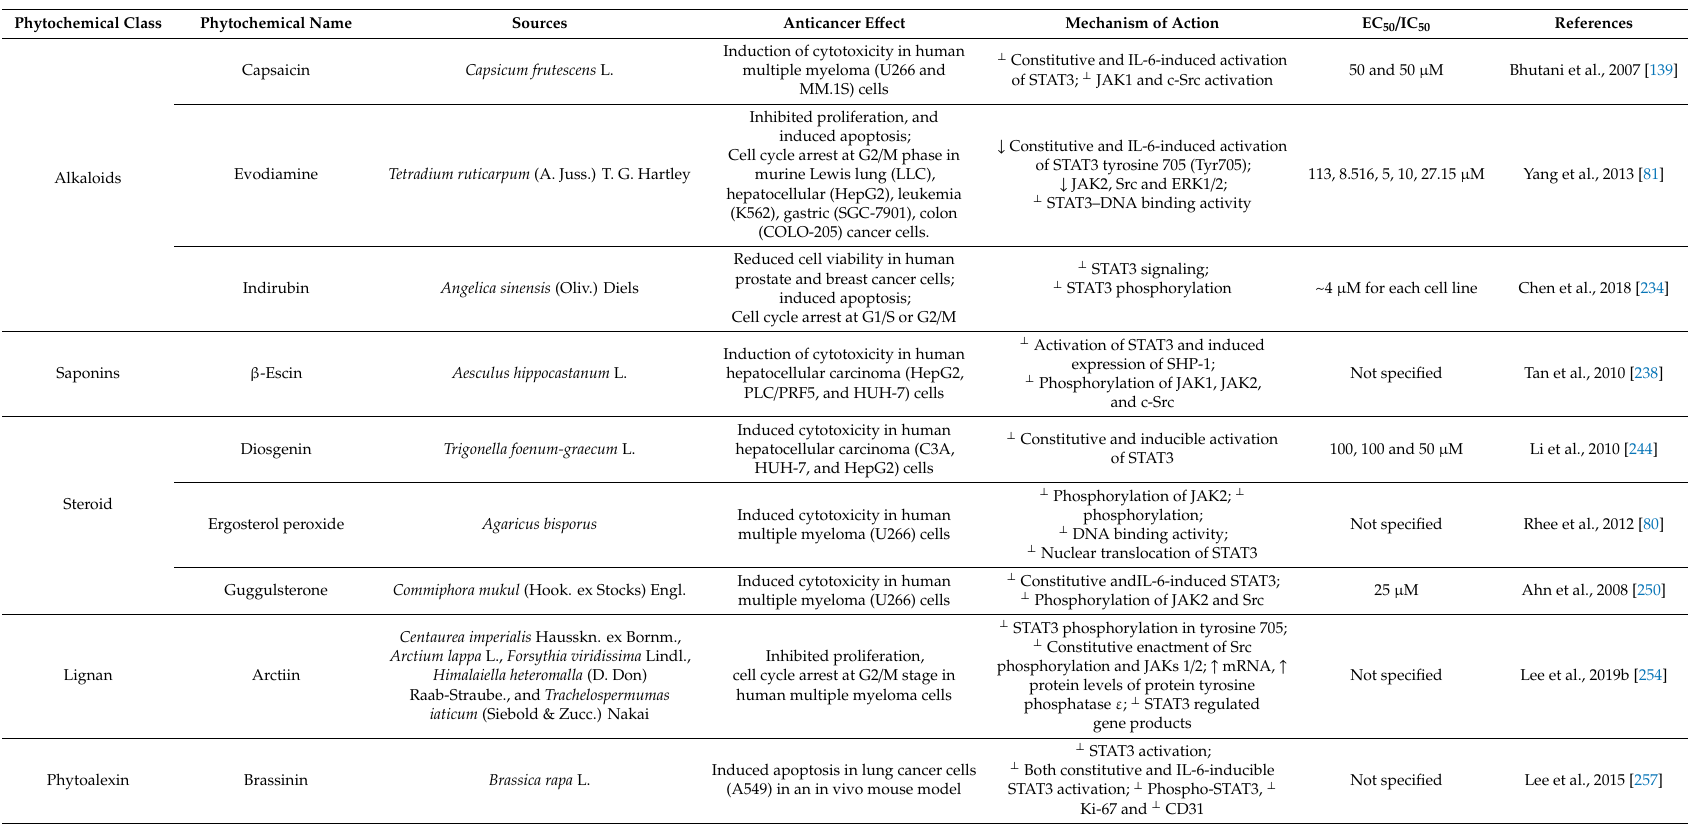
Table 3. Anticancer activities of alkaloids, saponins, steroids, lignan, and phytoalexin related to inhibition of the JAK / STAT signaling pathway. Phytochemical